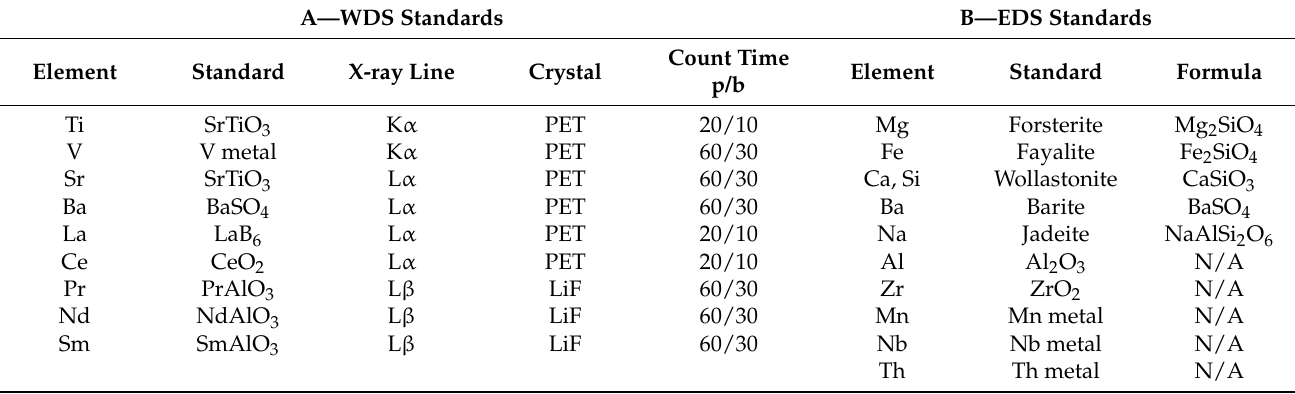
Table 2. Details of WDS analysis for minor and trace elements, including X-ray line, standards, diffracting crystal, and count times peak/background selected appropriately to the concentration of an element in the mineral. B–standards used for the EDS